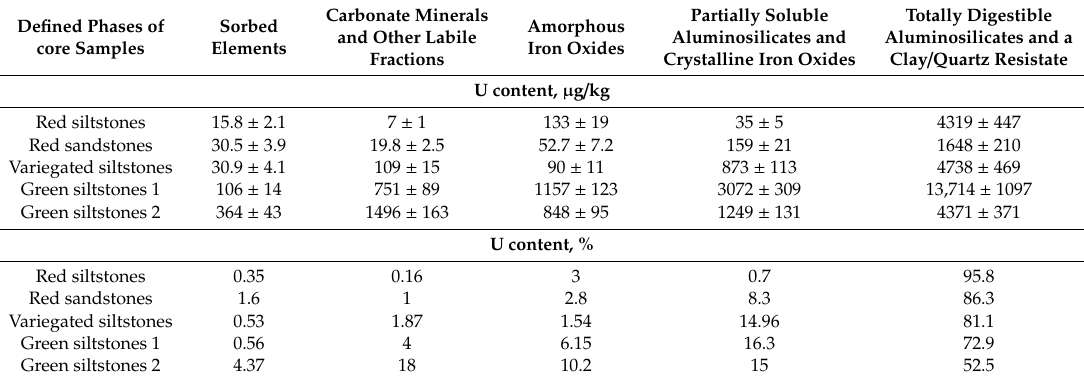
Table 3. Distribution of uranium in the mineral